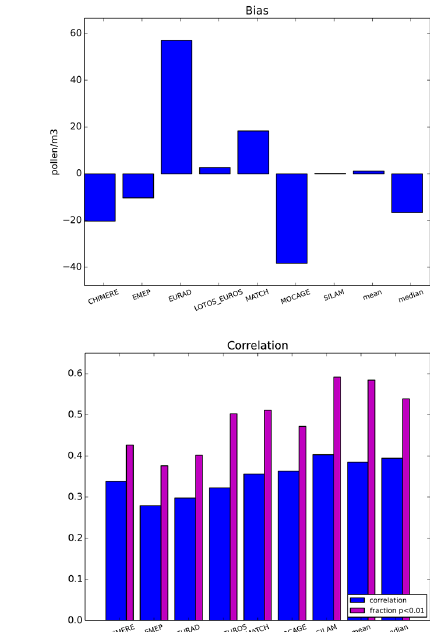
Correlation coefficient (Fig. 7) should be taken with